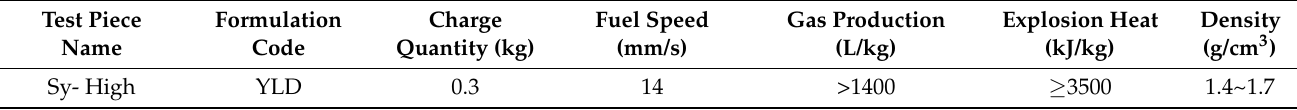
Table 2. Fracturing agent (test piece) performance